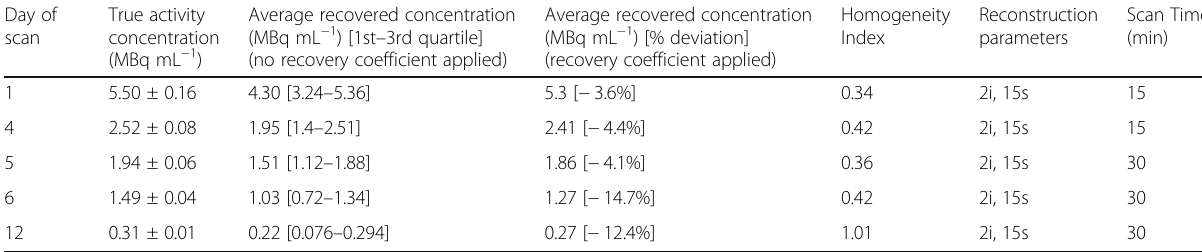
Table 2 Recovered activity in the tumor insert before and after compensation for partial volume effect through recovery coefficients. Recovered activity concentrations are compared to measured values Day of